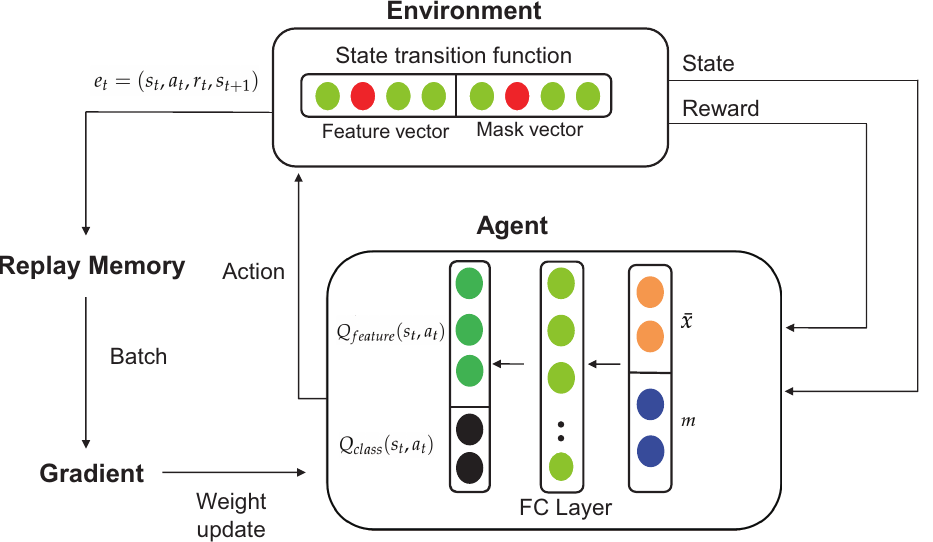
Figure 3. Procedure for extracting features from EEG and ECG signals with the reinforcement learning